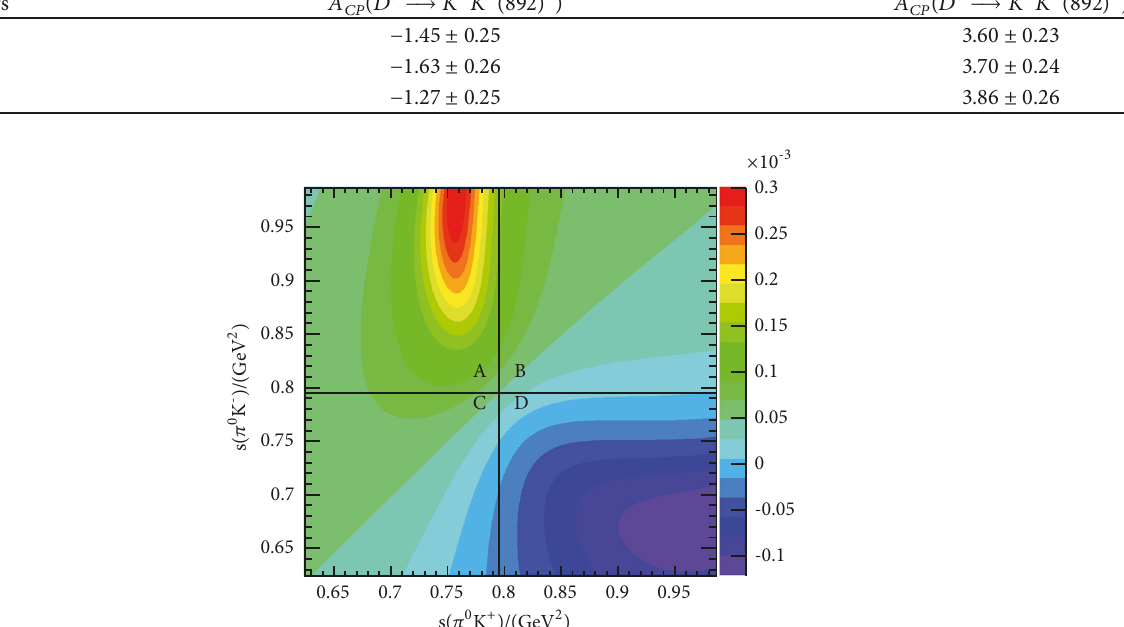
Figure 2: The differential 𝐶𝑃 asymmetry distribution of 𝐷 0 󳨀→ 𝐾 + 𝐾 − 𝜋 0 in the overlapped region of 𝐾 ∗ (892) − and 𝐾 ∗ (892) + in the phase